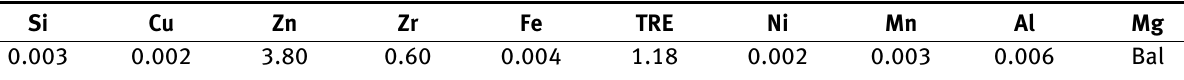
Table 2: Chemical composition of ZE41A magnesium alloy Si Cu Zn Zr Fe TRE Ni Mn Al Mg 0.003 0.002 3.80 0.60 0.004 1.18 0.002 0.003